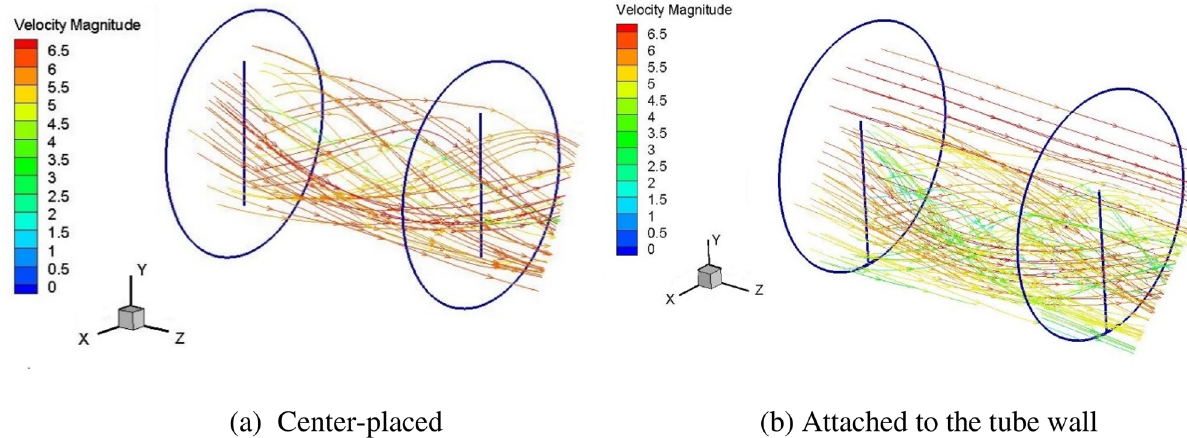
Figure 5. The stream line inside tube with twisted inserts at Re of 2600.